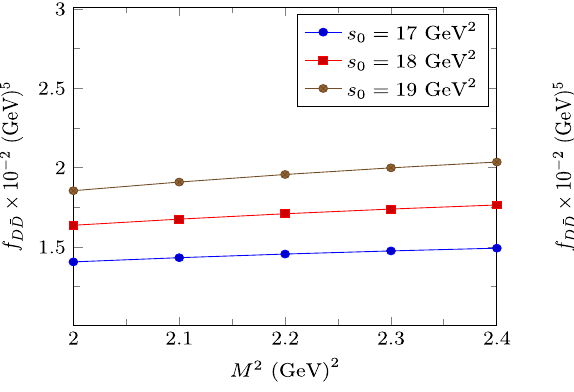
Fig. 2 Same as in Fig. 1, but for the coupling f of the D ¯ D state